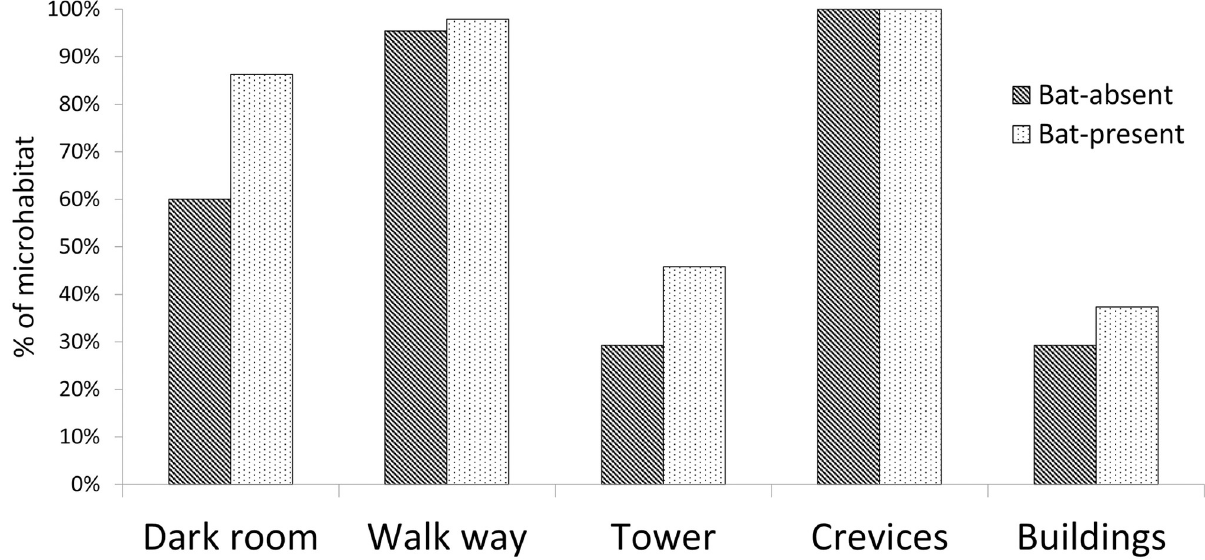
Fig 5. Percentage availability of habitats in temples with and without bats.